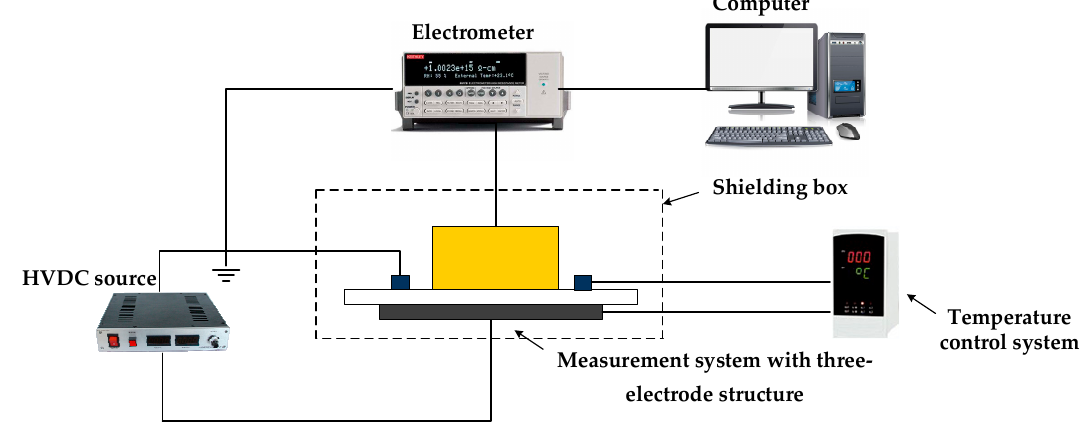
Figure 6. Schematic diagram of the measurement system.